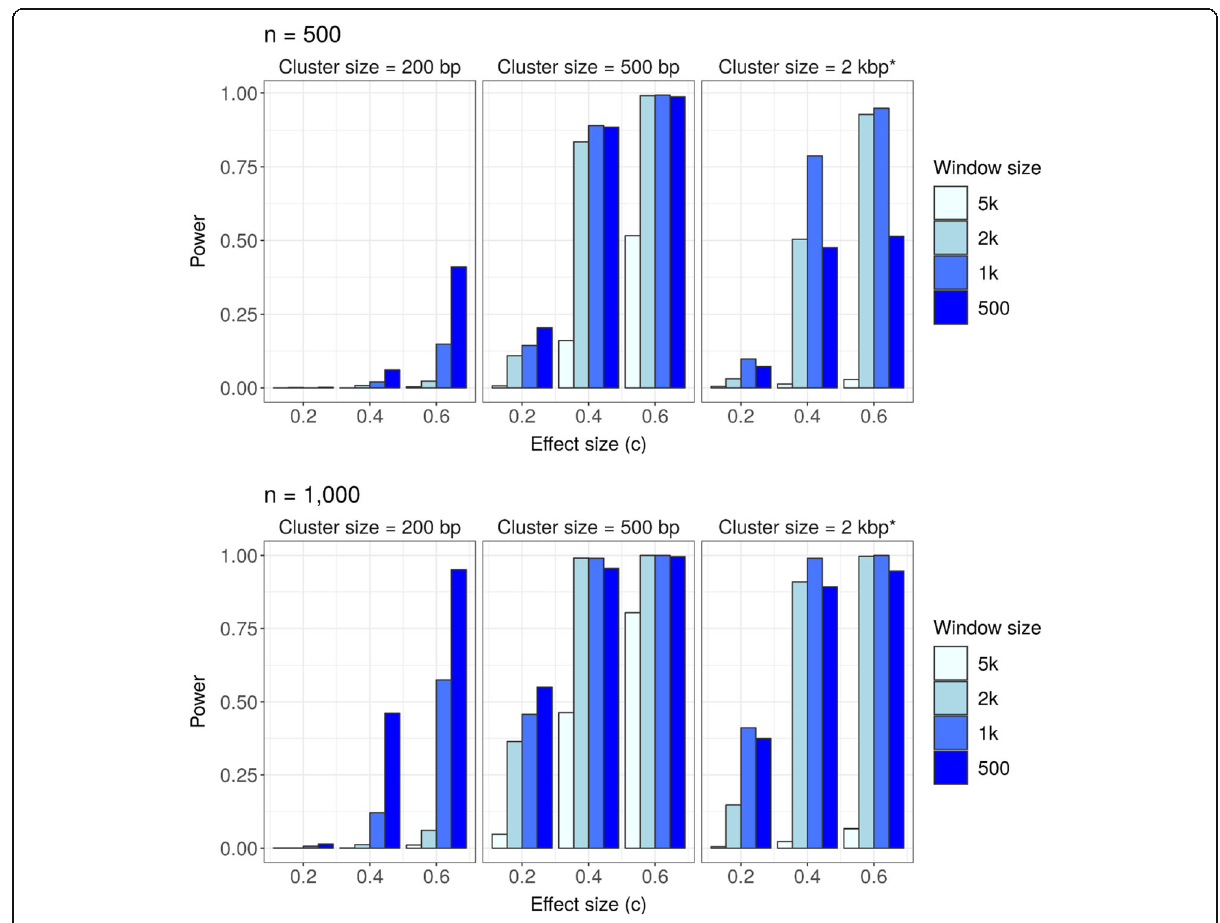
Fig. 2 Empirical power for QPSS to detect any targeted sliding window (one containing true disease-related variants). * Cluster size = 2 kbp contains 20% disease-related